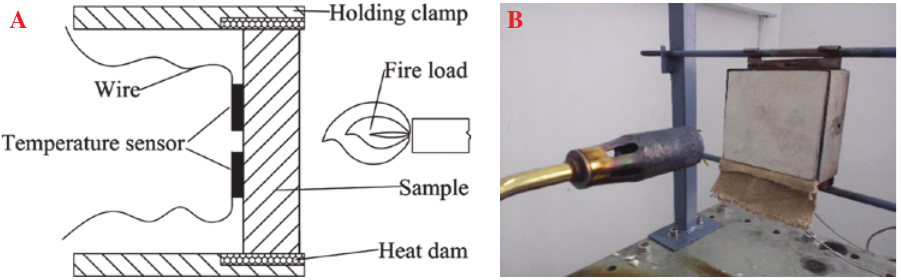
Figure 6: The fire-proofing testing apparatus: (A) schematic; (B)